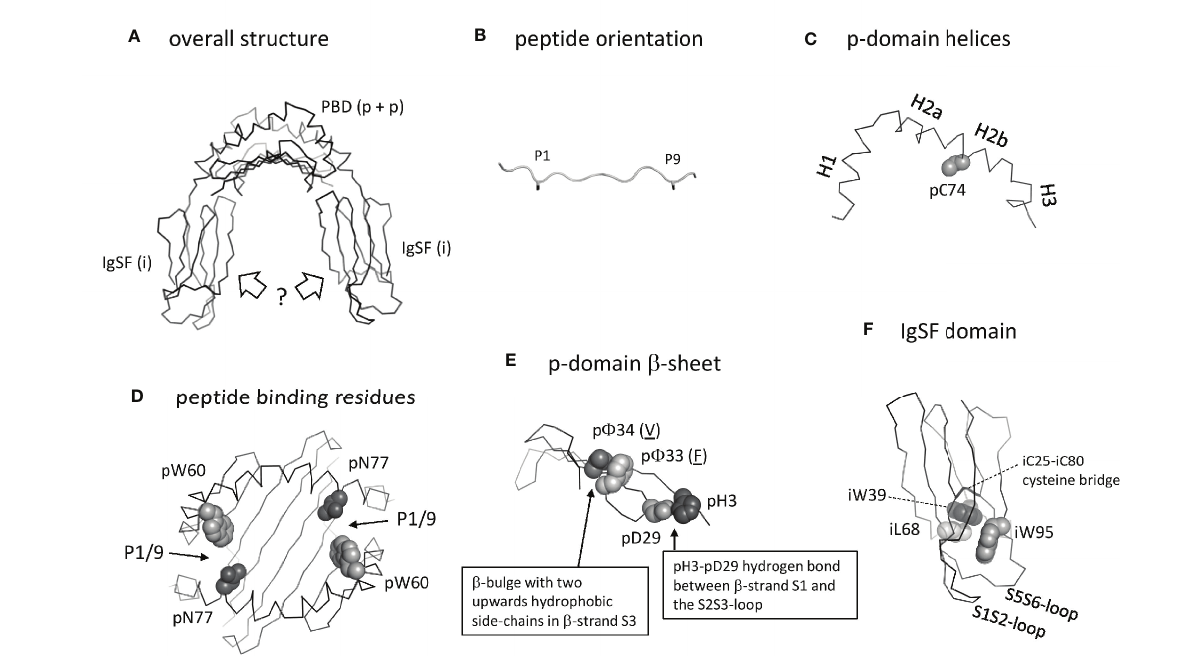
acquisition/ fi xation of a large set of interacting residues [ Figure 7A (a) and Supplementary Files 1A , 2A, B , 3A ]. In our joint study we provided experimental evidence by alanine exchanges showing that all four b 2 -m residues iaY10, iaD53, iaF56, and iaW60 are important